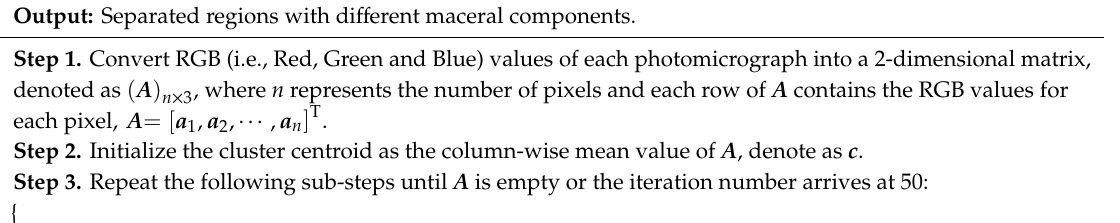
Figure 3. The flowchart of random forest for regression. OOB, out of bag.